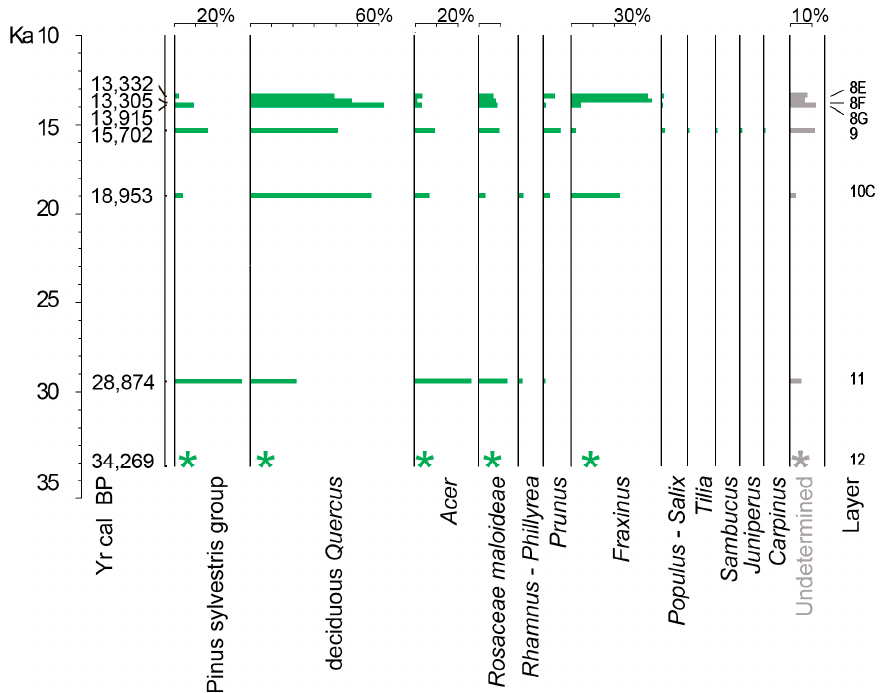
Figure 2. Charcoal percentages of the Serratura Cave plotted against age (y cal BP). Calibrated age BP are expressed as the median probability age.